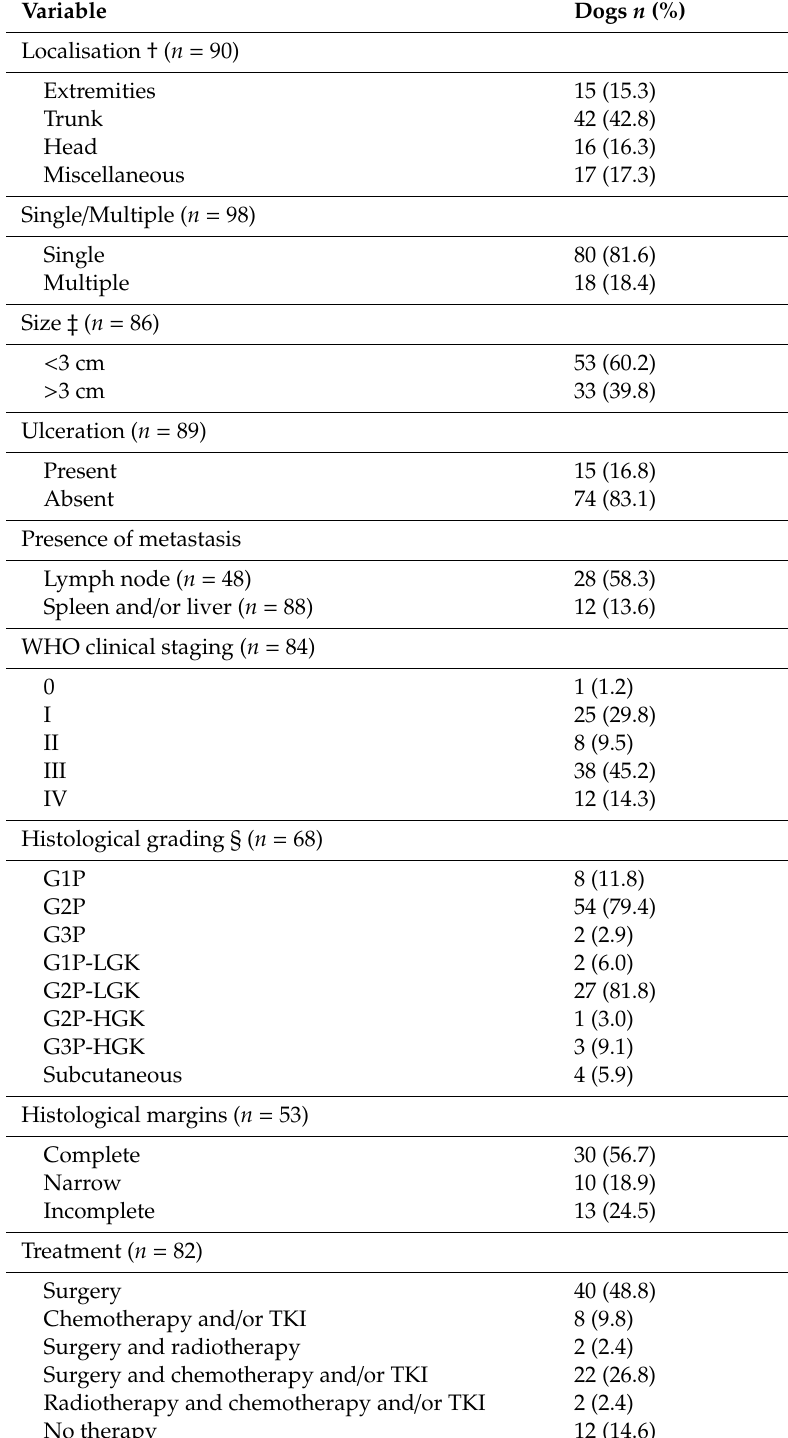
Table 3. Clinical data distribution regarding the ninety-eight dogs with